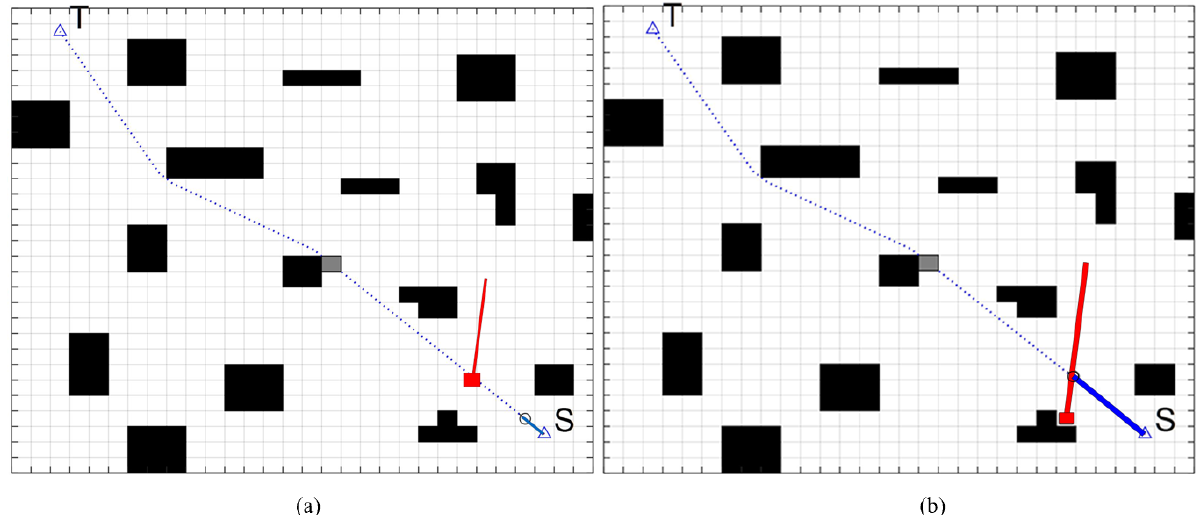
Figure 12. Dynamic obstacles for high-speed movement. ( a ) There is an unknown high-speed dynamic obstacle in front of the FAGV and it is predicted that the FAGV will not collide with the obstacle. ( b ) FAGV continues on the current path.